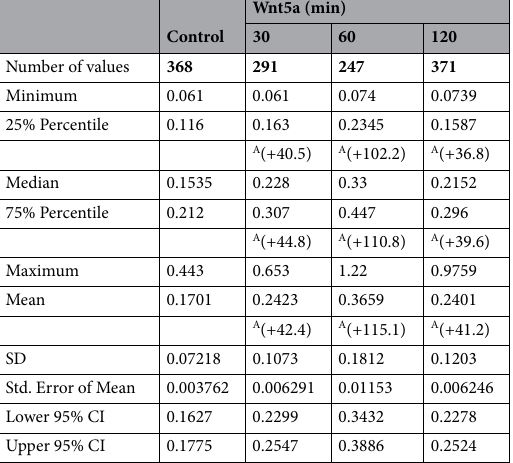
Table 1. Percentile values and statistical analysis of the length of post-synaptic density from EM images. PSD length values grouped by percentile for each treatment. The values are represented in micrometers 2 (µm 2 ) and “A” corresponds to the percentage of increase in PSD length of each group when compared to the corresponding Control group. The significance of bold (Number of values) indicates the number of dendritic spines analyzed for each